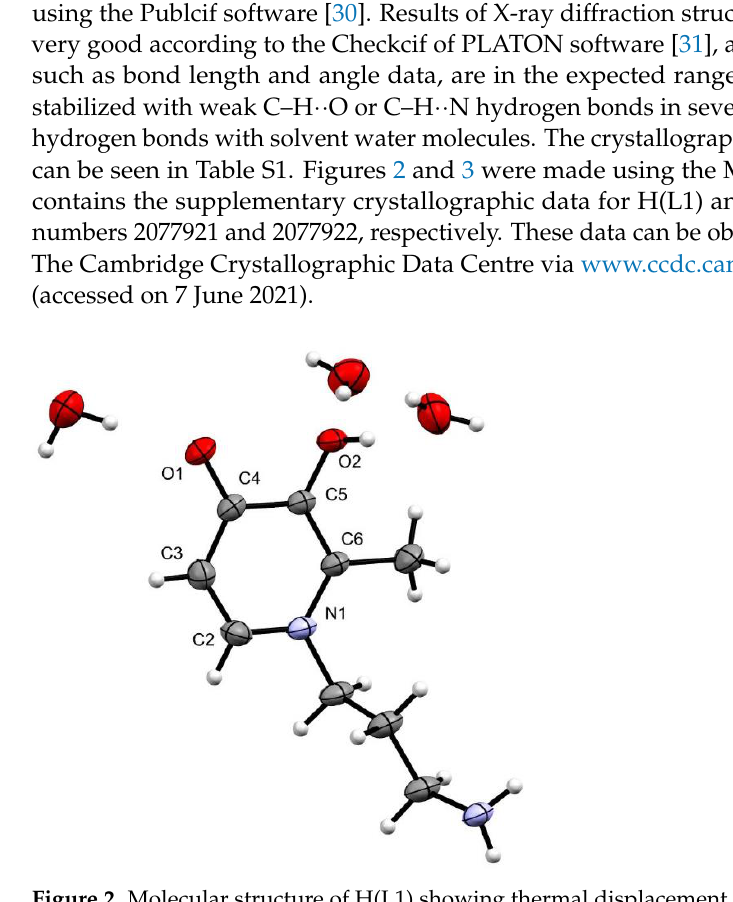
Figure 2. Molecular structure of H(L1) showing thermal displacement ellipsoids, drawn at the 50% probability level. Key bond lengths (Å) and angles ( ◦ ) are C4-O1 1.289(3), C5-O2 1.315(3), C3-C2 1.372(3), C6-C5 1.392(3), C2-N1 1.341(3), C6-N1 1.372(3); O1-C4-C5 119.38(19), O2-C5-C4 119.66(18),